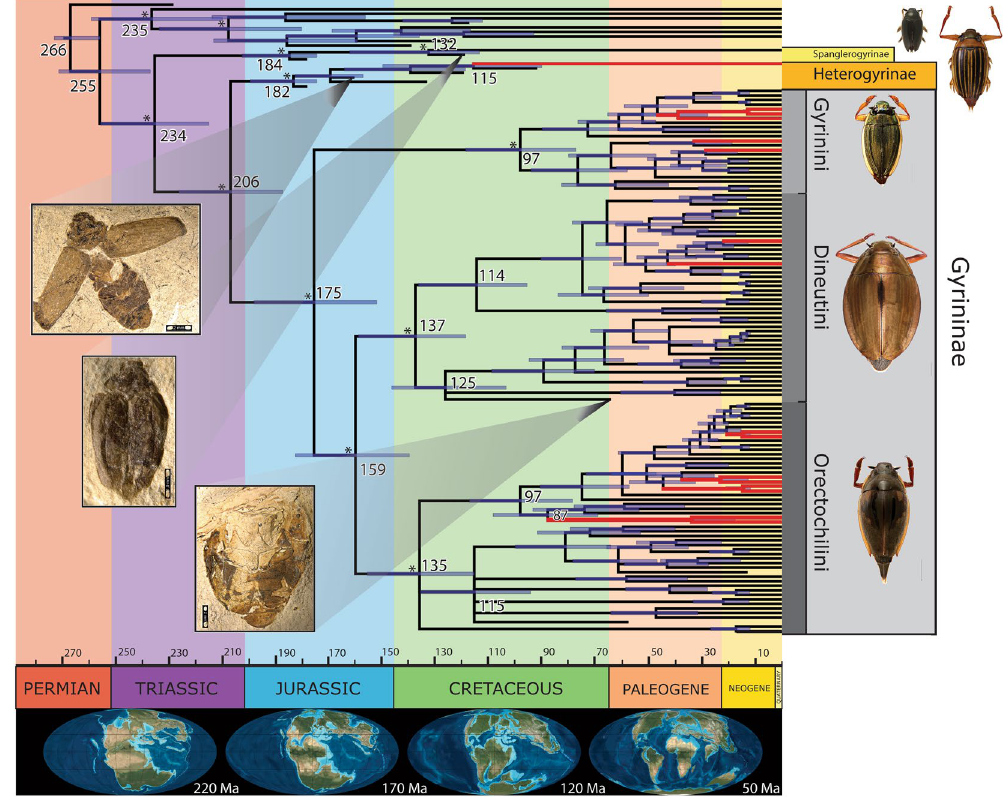
Figure 1. Total evidence dated phylogeny of Gyrinidae. Majority-rule consensus tree from Bayesian analysis using fossils as terminals under the FBD tree prior. Dates at selected nodes represent median posterior age estimate and blue bars show the 95% highest posterior density age range. The asterisk above nodes indicates support of ≥ 0.95 posterior probability (only indicated for basal nodes). Malagasy lineages are coloured red. Fossils and imaged exemplars not to scale. The paleogeographic maps below© 2012 Colorado Plateau Geosystems used with